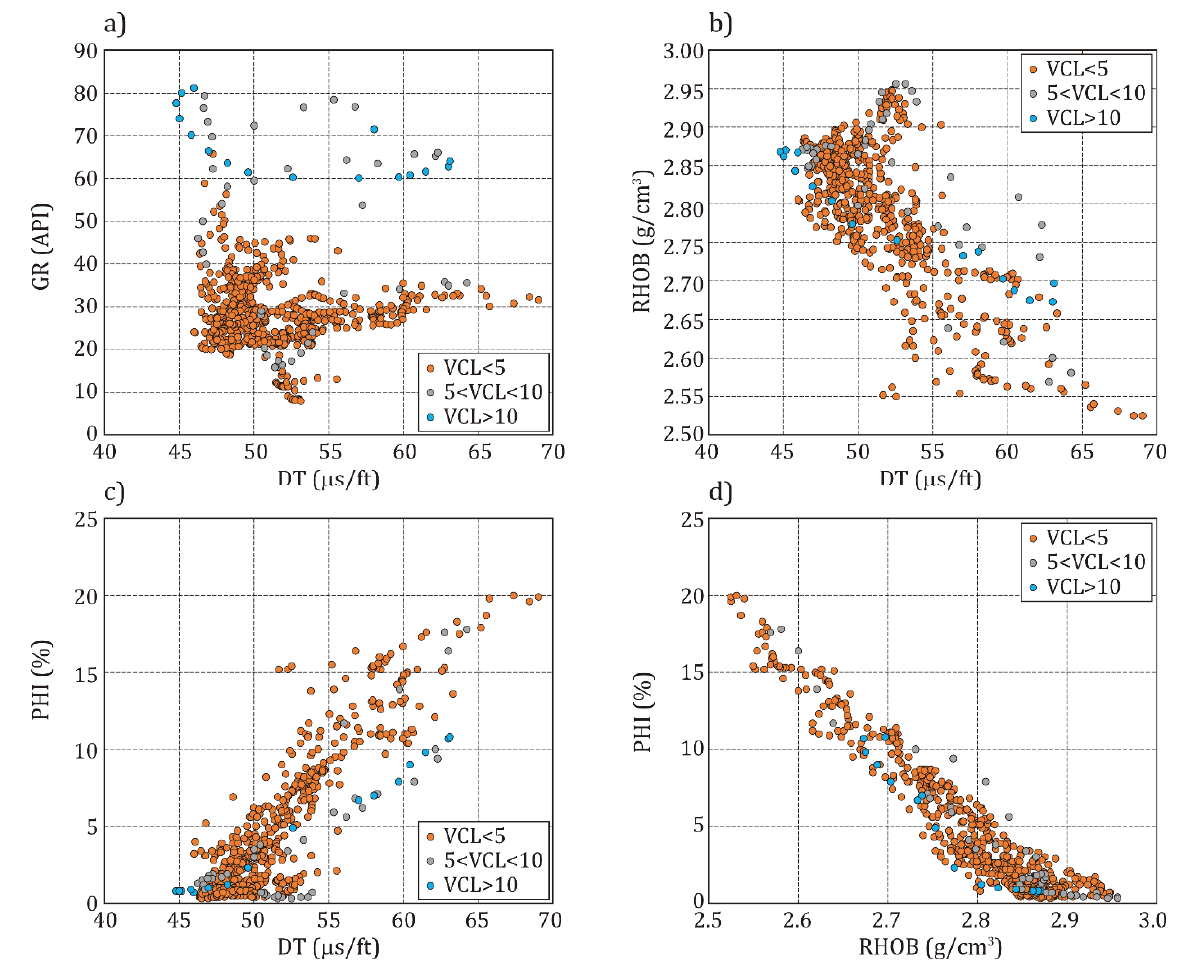
Figure 6. Mutual relations between well logging data in G-5 borehole; division according to shaliness; ( a ) GR vs. DT, ( b ) RHOB vs. DT; ( c ) PHI vs. DT, ( d ) PHI vs. RHOB.